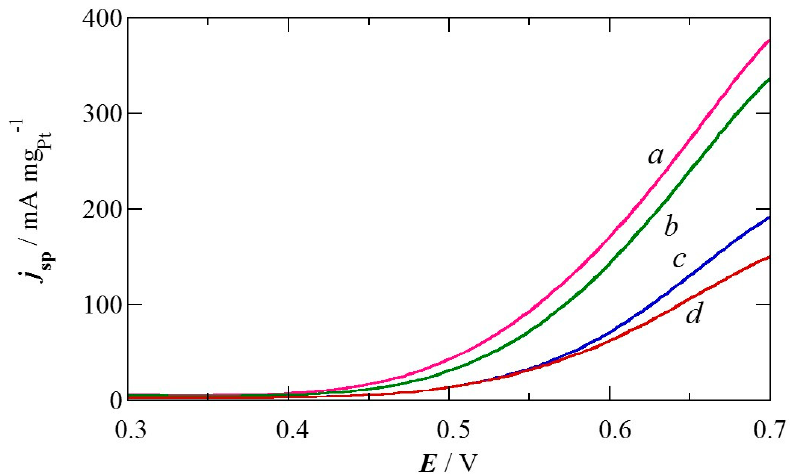
Figure 9. Linear sweep voltammograms corresponding to the methanol oxidation in 1.0 M CH 3 OH + 0.5 M H 2 SO 4 on different Pt ‐ Ru(Cu)/C electrocatalysts synthesized from spontaneous deposition times of 22 (curve a ), 30 (curve b ), 10 (curve c ) and 40 min (curve d ), following the sequence iii . Sweep rate 20 mV s − 1 .